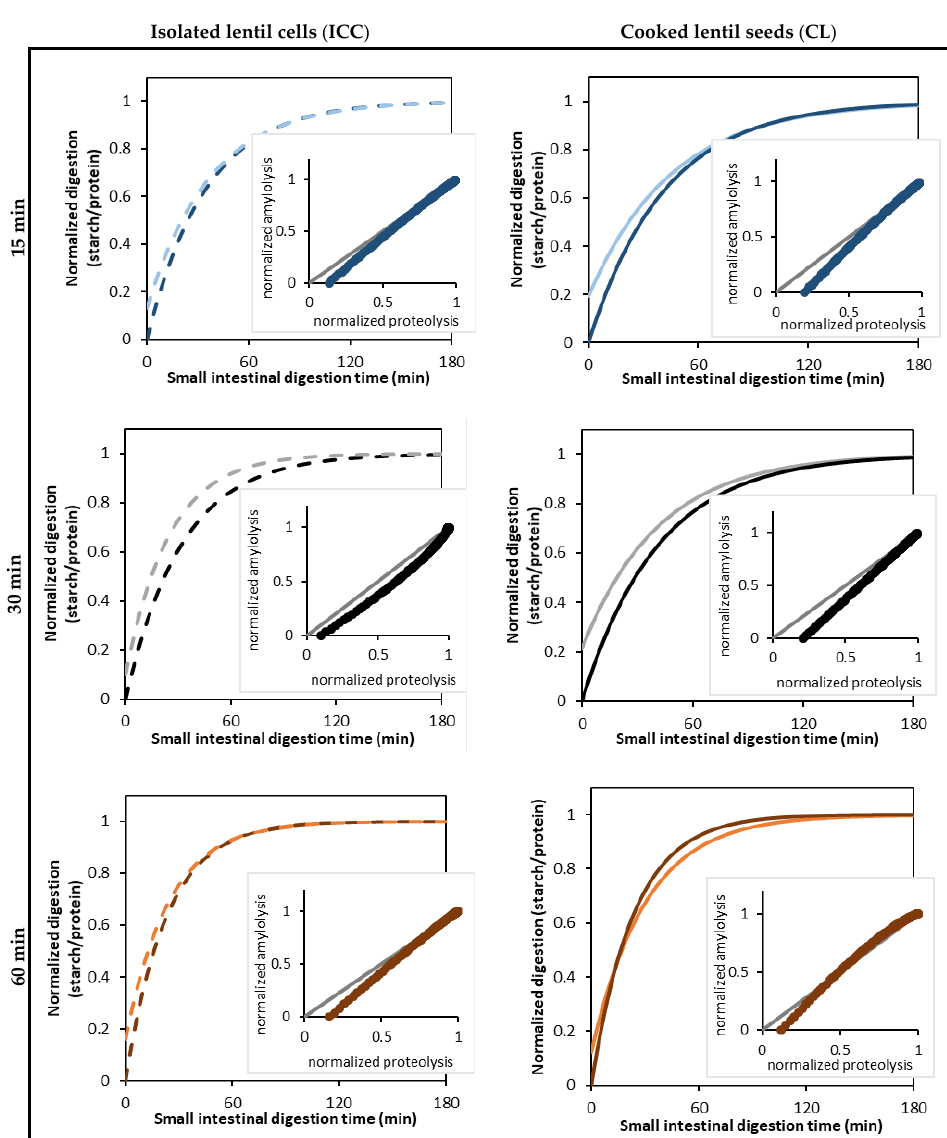
Figure 7. Normalized parameter estimates of readily bioaccessible protein (bright color) formation and amylolysis (dark color) kinetics during the in vitro small intestinal digestion of isolated cotyledon cells (ICC, left, dotted lines) and whole cooked lentils (CL, right, full lines) cooked for 15 ( - / - ), 30( - / - ), and 60 ( - / - ) minutes. The kinetic parameters for amylolysis and proteolysis were estimated by fitting the experimental data to a fractional conversion model (Equation (3)). The inserted scatter shows the correlation analysis of amylolysis and proteolysis, with the grey diagonal ( - ) indicating the case of identically progressing proteolysis and